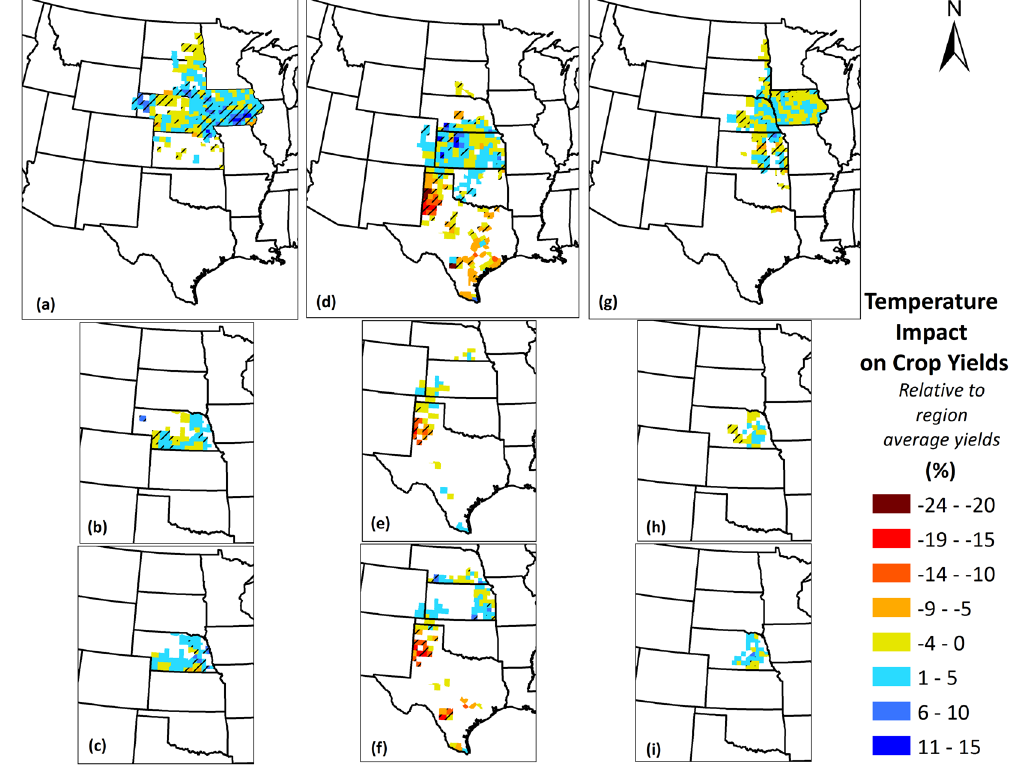
Figure 10. Temperature-induced crop yield impacts for ( a ) Maize; ( b ) Irrigated maize; ( c ) Non-irrigated maize; ( d ) Sorghum; ( e ) Irrigated sorghum; ( f ) Non-irrigated sorghum; ( g ) Soybean; ( h ) Irrigated soybean; ( i ) Non-irrigated soybean yields in the Great Plains counties over the period 1968–2013. Values are represented as percentage of region-average yields. A positive sign indicates that the observed trends in temperature whether increasing or decreasing, have positively impacted crop yields, while a negative sign indicates that observed trends in temperature have negatively impacted crop yields. Counties with striped lines indicate that the temperature-induced impacts were statistically significant at 90% confidence level. We created the maps using ESRI ArcMap 10.4.1 software